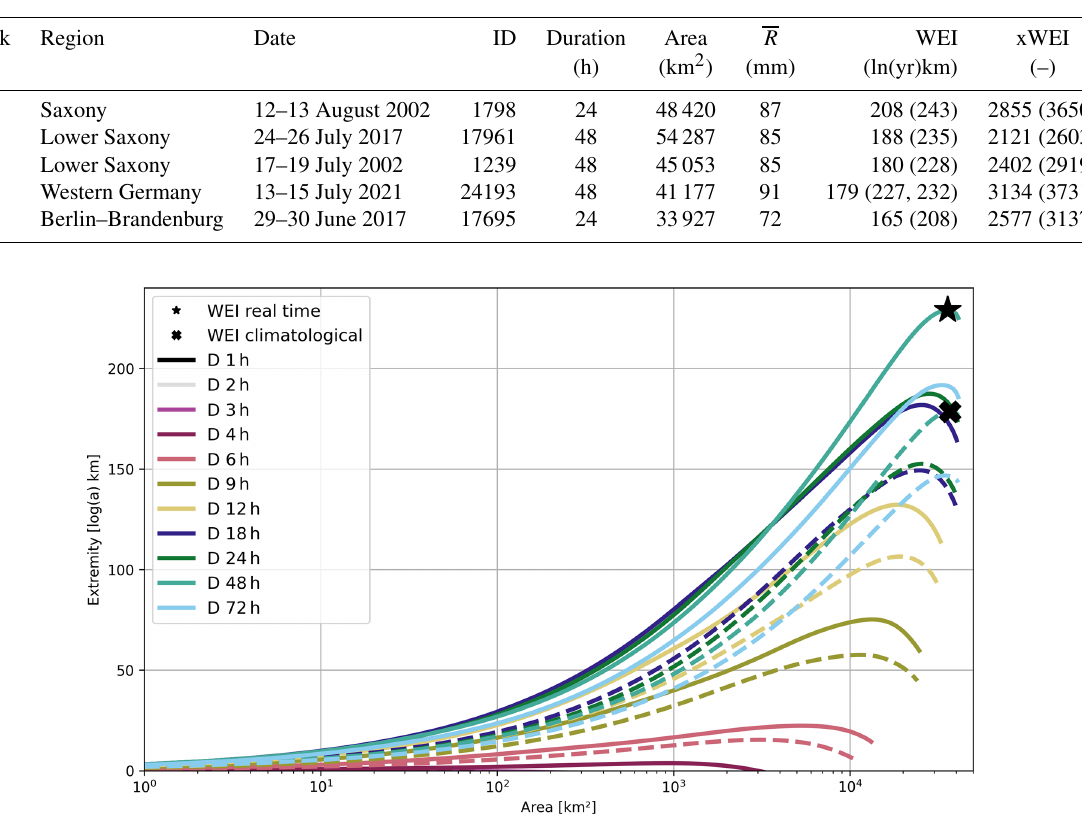
Table 1. The five most extreme precipitation events in CatRaRE v2022.01, according to the weather extremity index (WEI), and the corre- sponding cross-scale weather extremity (xWEI) values for the same events. In brackets, we show the values obtained with GEV parameters that do not account for the year of the event’s occurrence. For the July 2021 event, the second value in brackets was obtained with the real-time setup (based on operational radar data and without including the year 2021 in the GEV parameter estimation). Duration and area specify the duration and area at which the event reached its maximum extremity; R is the areal average of the event’s rainfall depth.